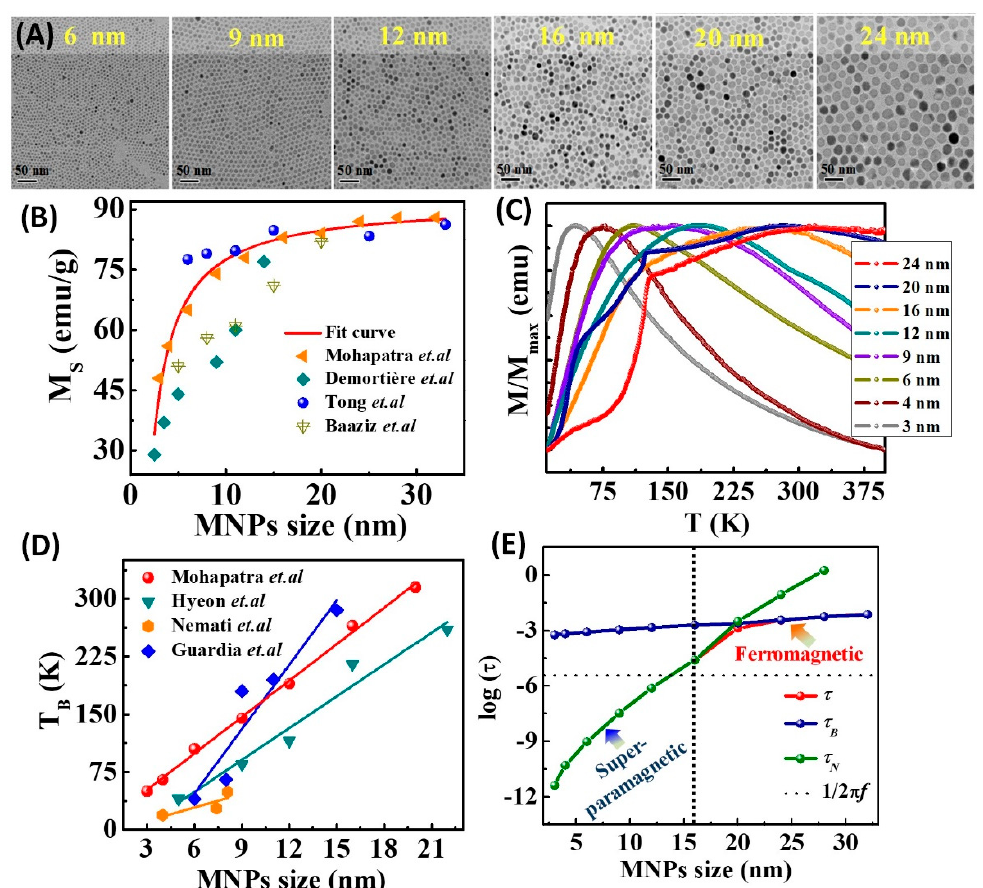
Figure 6. ( A ) The TEM micrographs of di ff erently sized Fe 3 O 4 nanoparticles. ( B ) A relationship between M S value and the nanoparticle size [71,76–78]. ( C ) The zero-field cooled (ZFC) magnetization curves of di ff erent sized Fe 3 O 4 nanoparticles [71]. ( D ) Blocking temperature ( T B ) versus nanoparticle size ‘ d’ [33,71,72]. ( E ) The variation of Neel relaxation time and Brownian relaxation time with Fe 3 O 4 nanoparticles size [71].